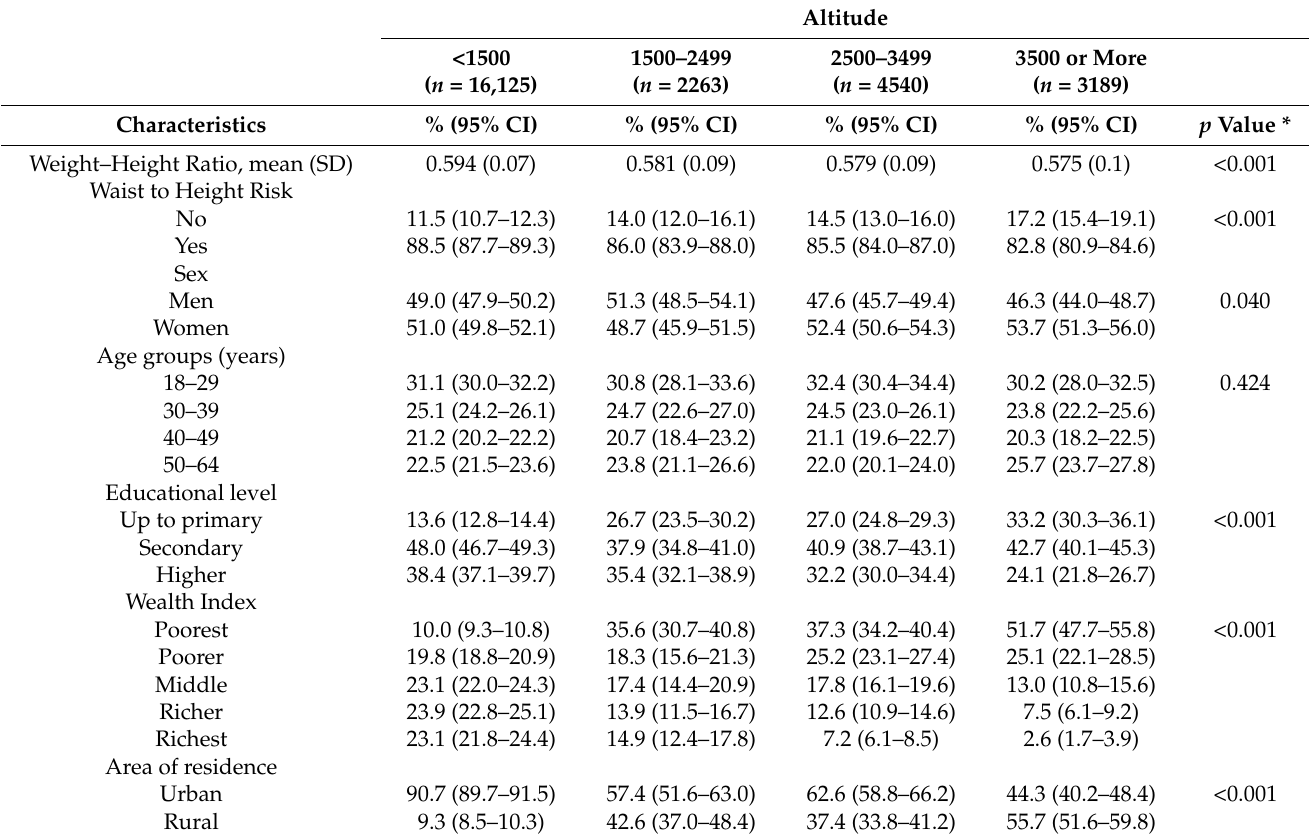
Table 2. Characteristics of the participants according to the altitude of